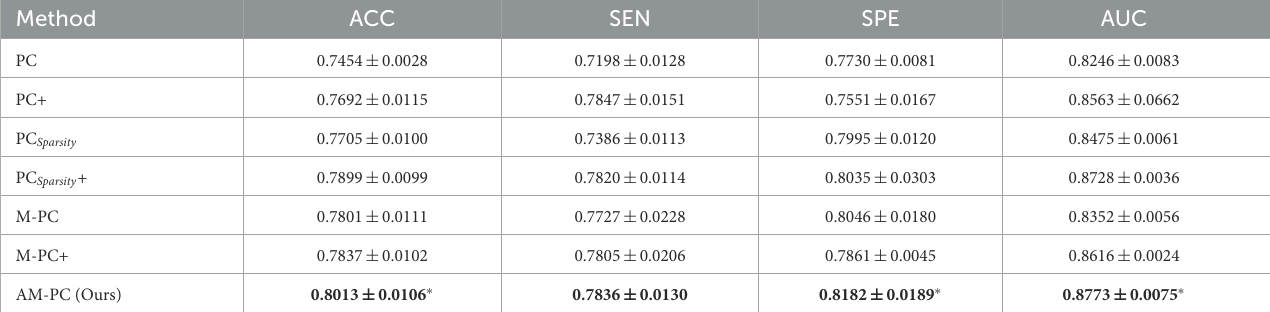
TABLE 2 Classification performance (mean ± standard deviation) of 7 different methods in MCI vs. NC classification.